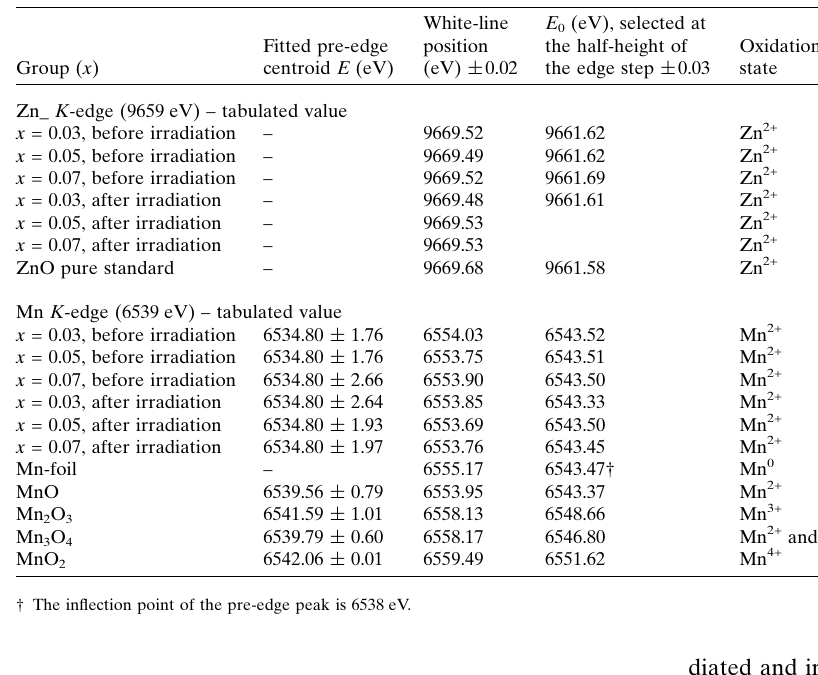
Table 2 Fitted pre-edge peak fitting of the different samples along with reference model compounds bearing Mn with different oxidation states, spectral white line position, absorption energies set as a fraction (half) of the edge step, oxidation states of the Zn and Mn cations in the reference compounds, and samples at both Zn and Mn K -edges.